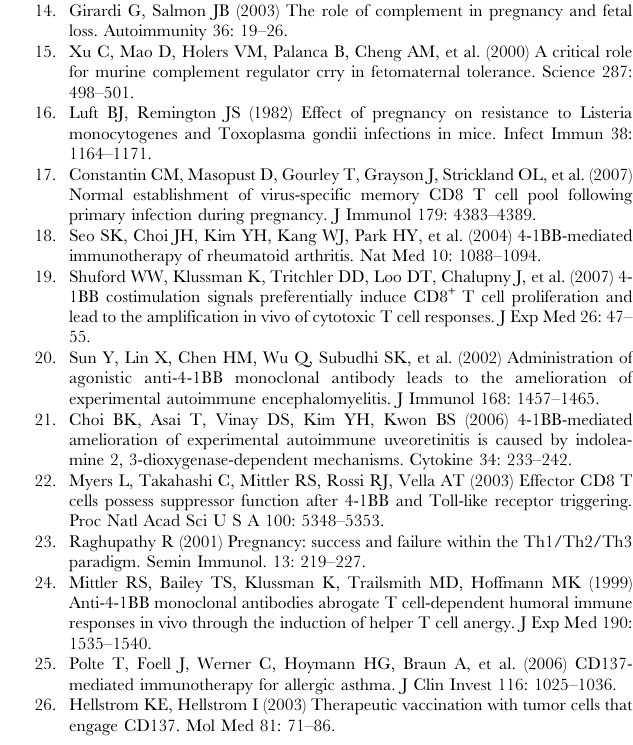
Figure S1 Impacts of 4-1BB triggering on splenocytes of the mice carrying syngeneic or allogeneic fetus. C57BL/6 male mice. The mice with vaginal plug and non-pregnant